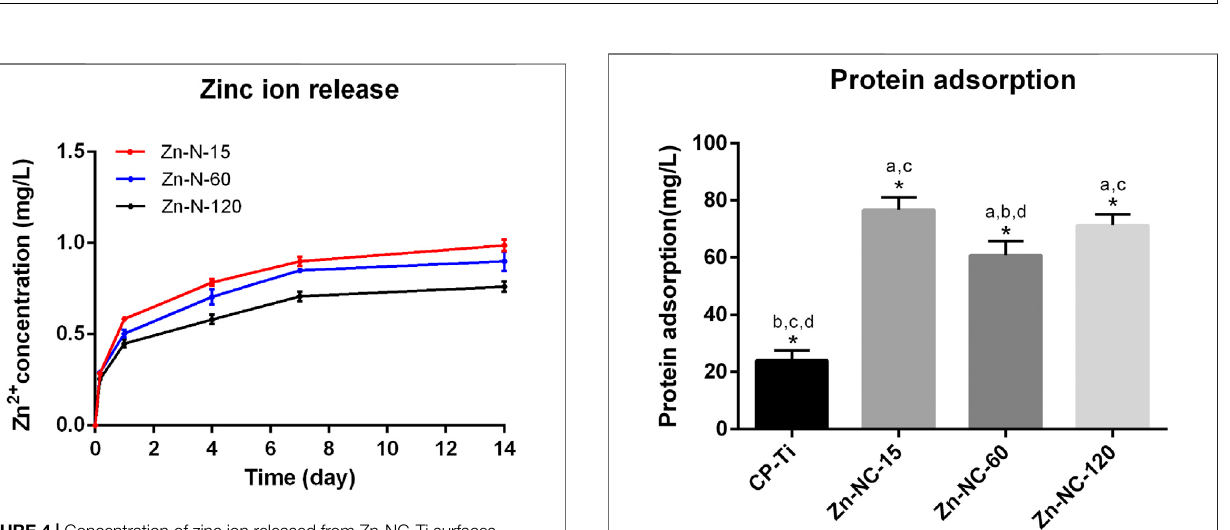
FIGURE 3 | Contact angles and surface energy of Cp-Ti and Zn-NC-Ti surfaces (n (cid:2) 3). * p < 0.05; a P < 0.05 vs. CP-Ti; b P < 0.05 vs. Zn-NC-15; c P < 0.05 vs. Zn- NC-60; d P < 0.05 vs. Zn-NC-120.